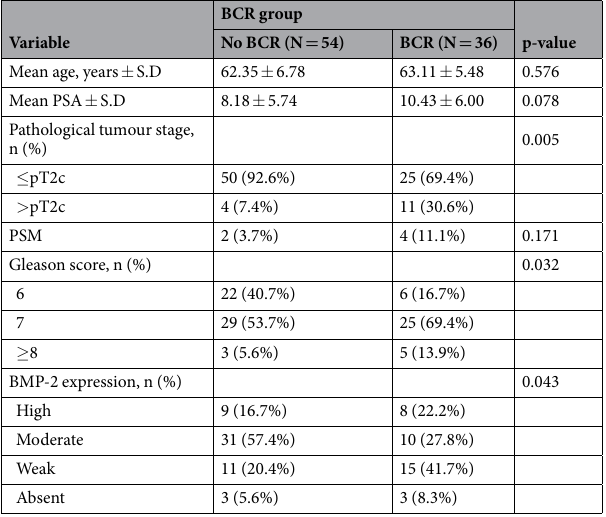
Table 2. Association of BCR with clinicopathological characteristics and expression of BMP-2 in 90 patients treated with radical prostatectomy for prostate cancer. S.D = standard deviation; BMP = bone morphogenetic proteins; PSA = prostate specific antigen; BCR = biochemical recurrence; PSM = post-operative surgical